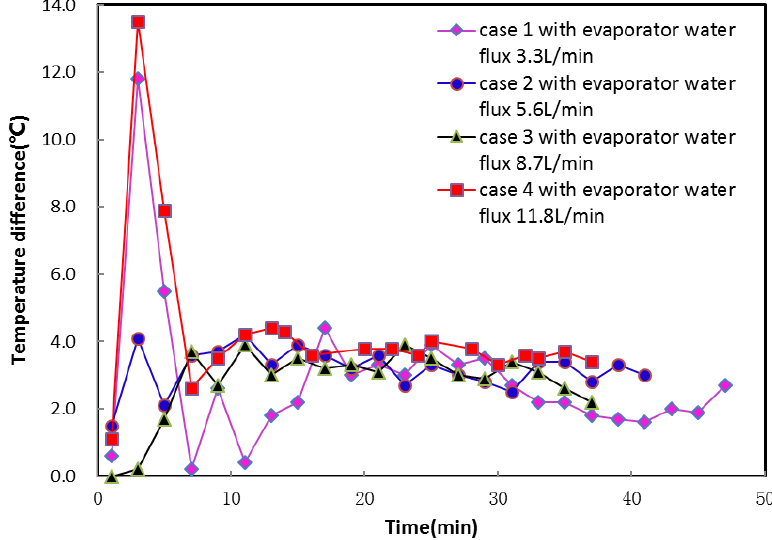
Figure 6. Evaporator inlet and outlet temperature differences with heating time.